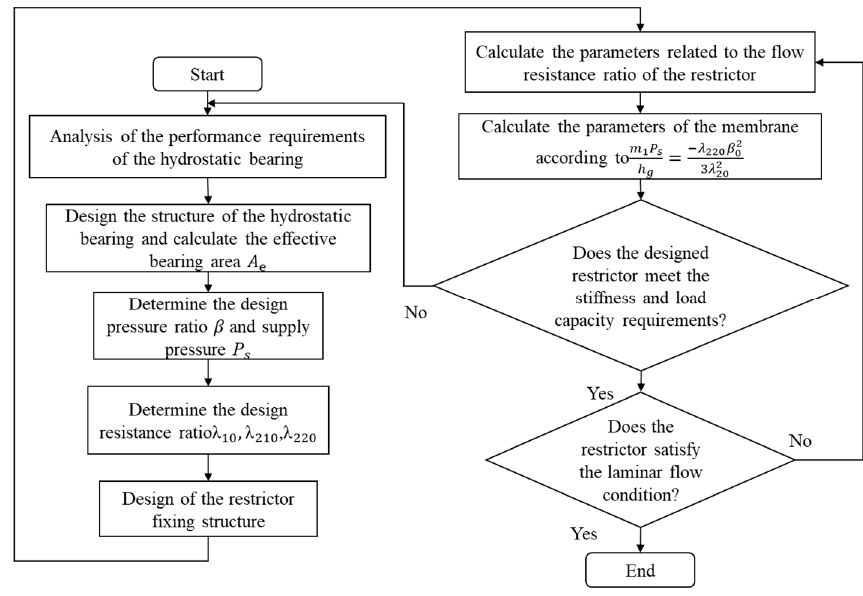
Figure 8. The design process of pre-pressure single-action membrane-type restrictor.